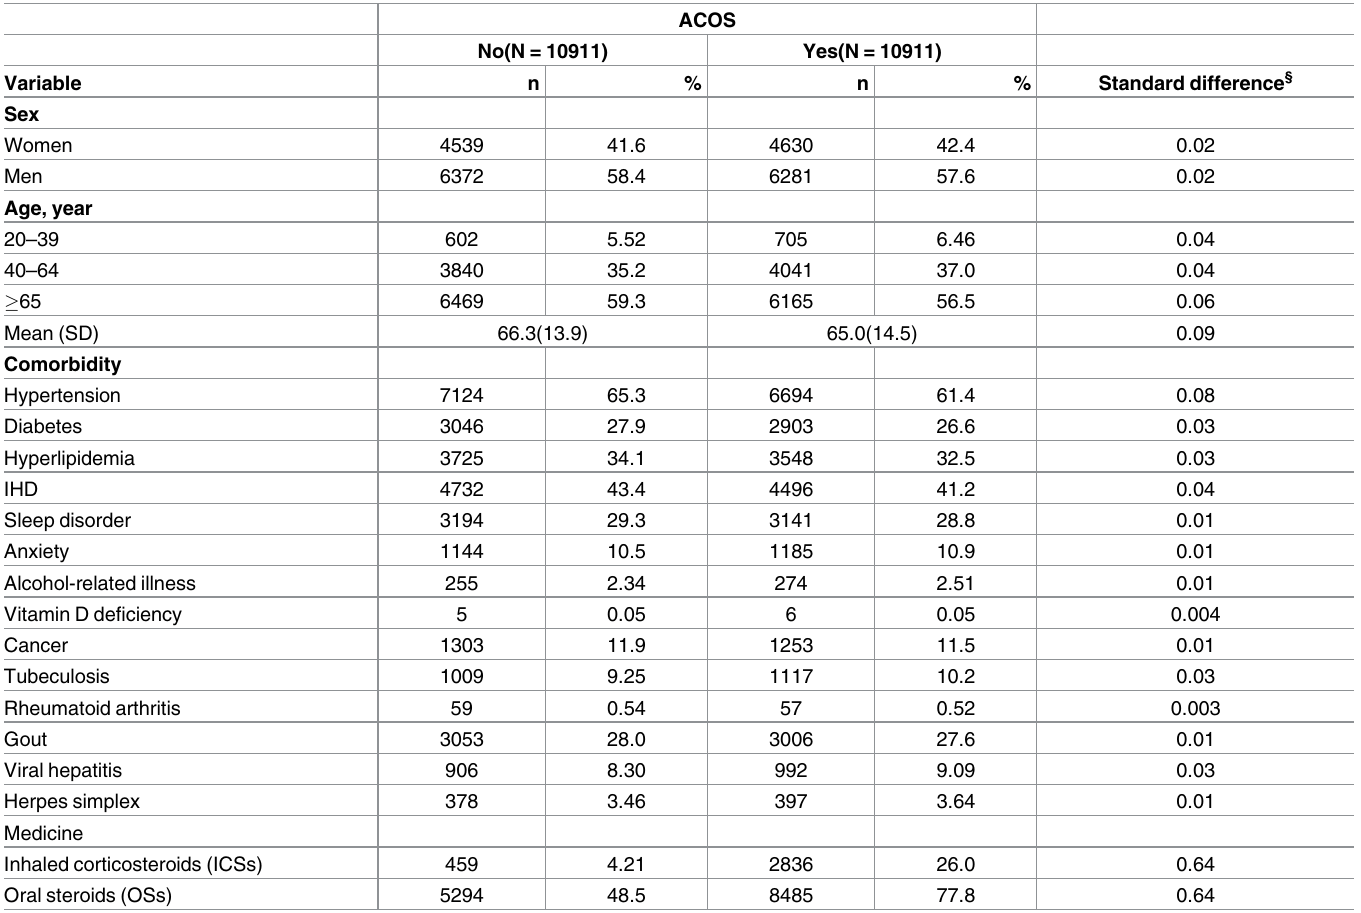
Table 1. Comparison of demographic risk factors between the ACOS and non-ACOS cohorts.